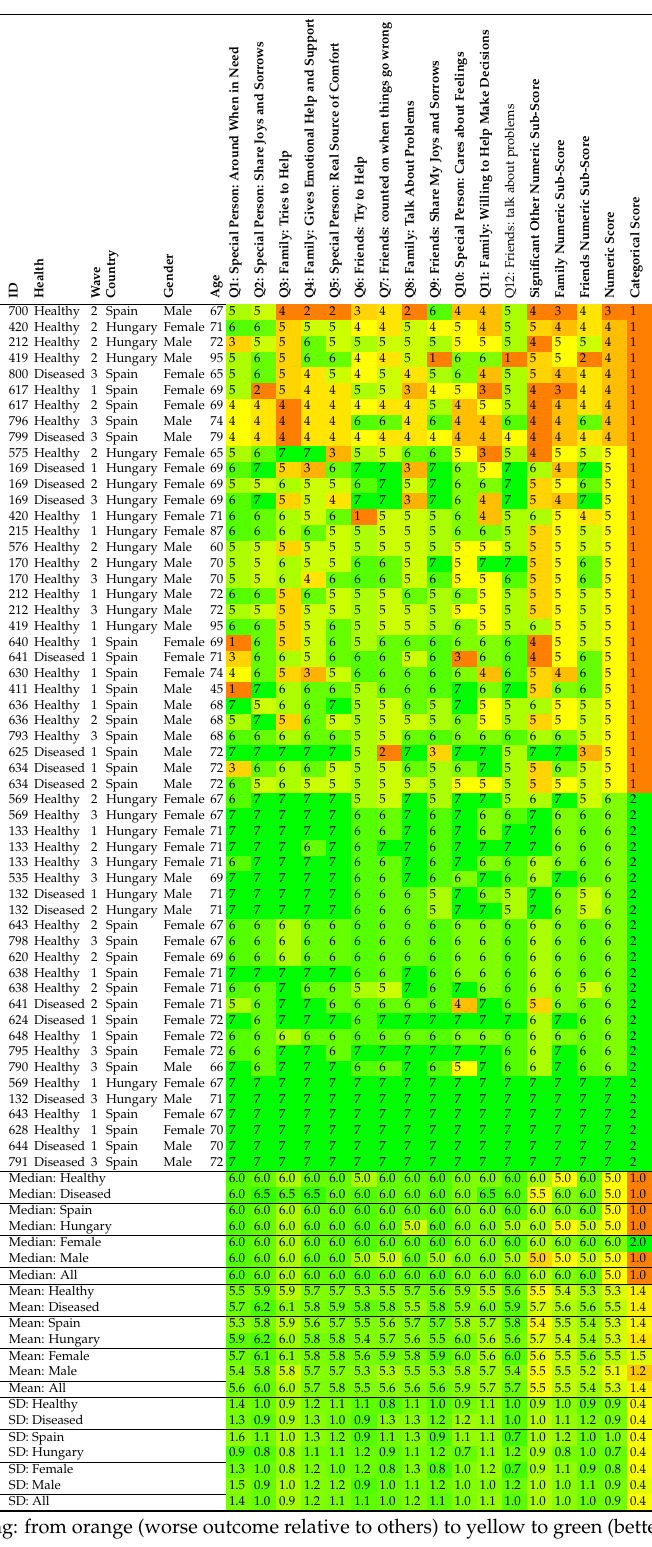
Table A4. Characteristics of PRO Social Support (MSPSS).